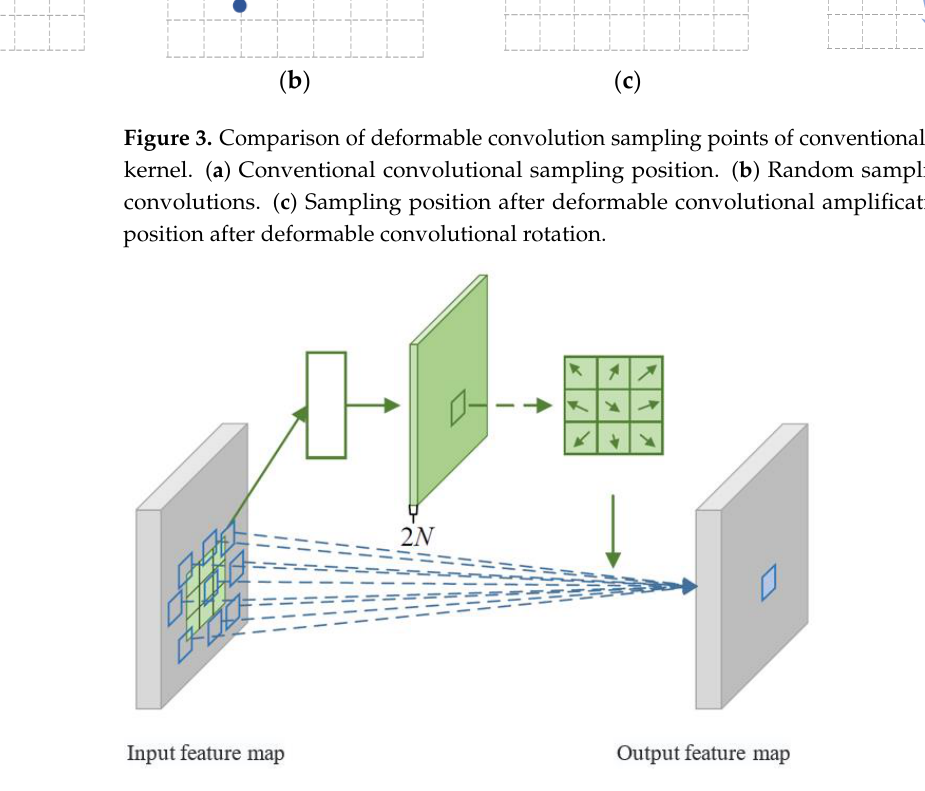
Figure 4. Calculation process of deformable convolution.